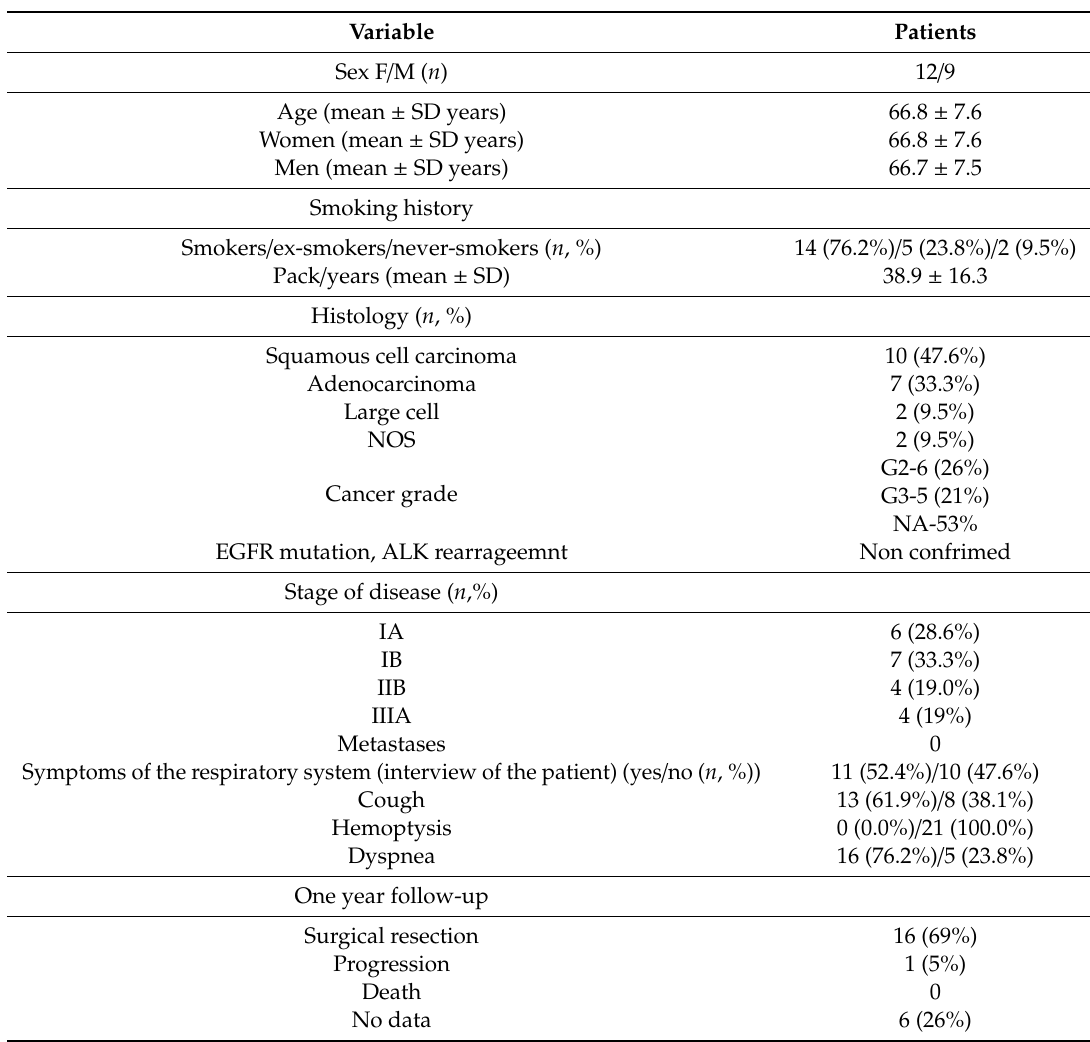
Table 1. Characteristics of the study population with lung